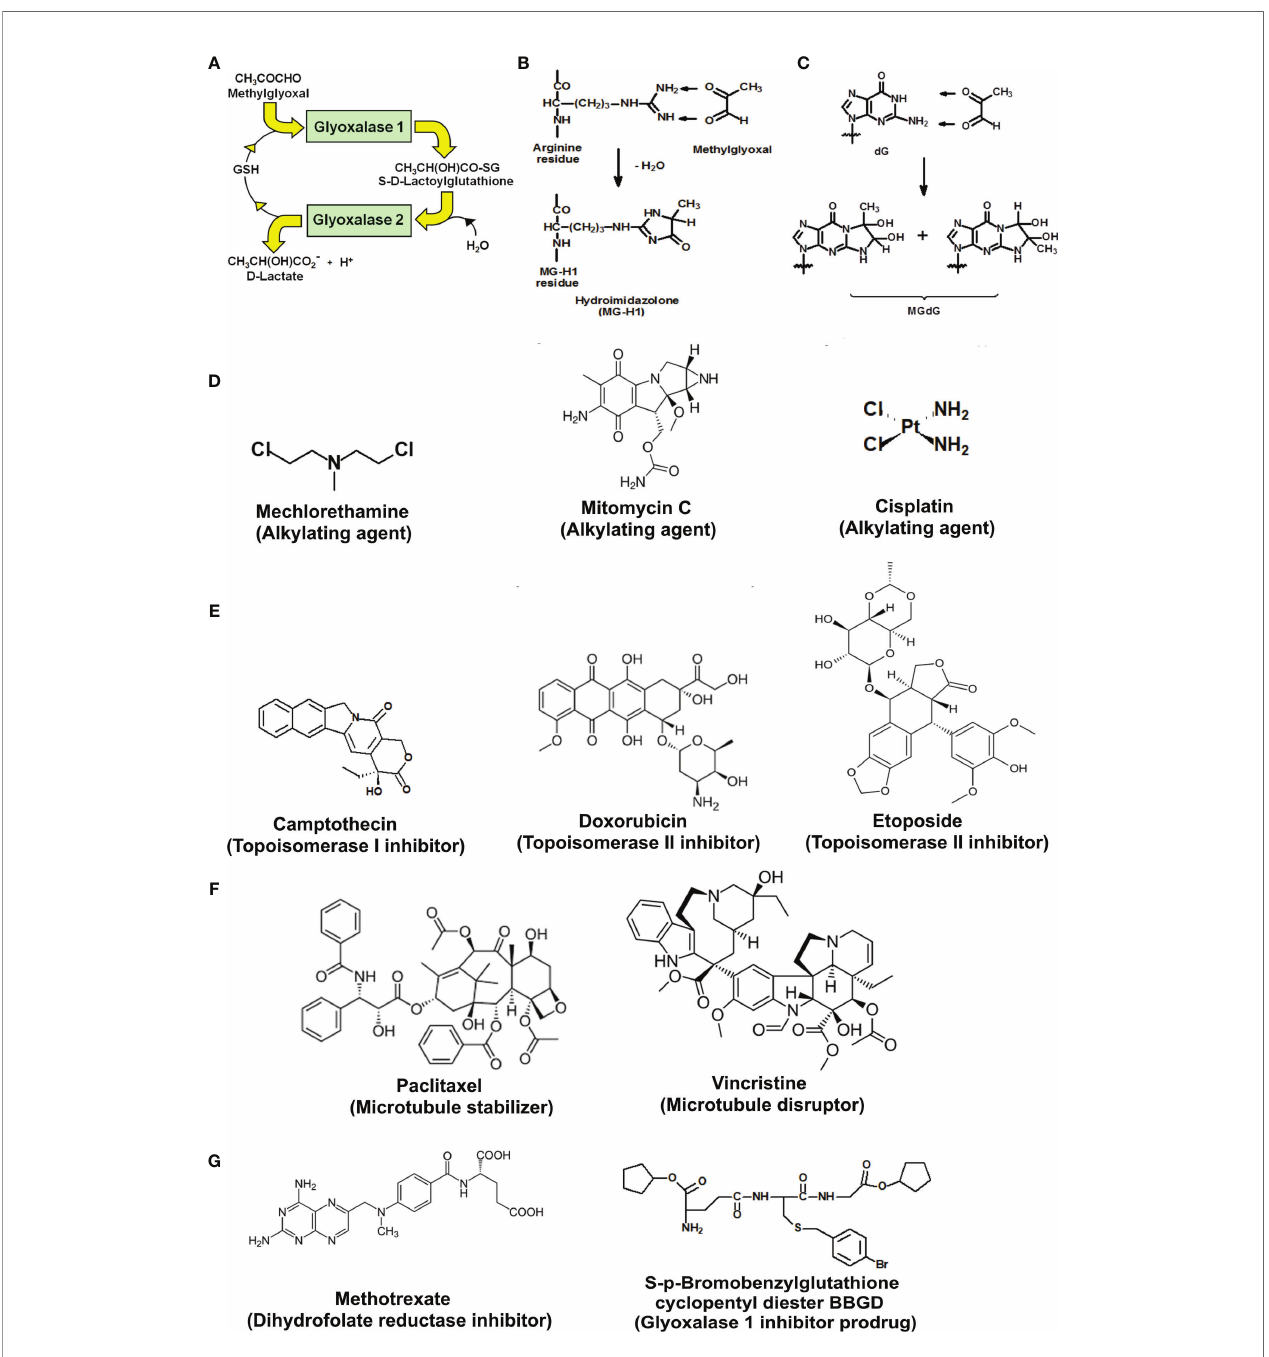
FIGURE 1 | Metabolism of methylglyoxal by the glyoxalase pathway, major glycation reactions of methylglyoxal and clinical and investigational antitumor drugs. (A) Metabolism of methylglyoxal by the glyoxalase pathway. (B) Glycation of arginine residues by methylglyoxal from hydroimidazolone, MG-H1. (C) Glycation of guanyl moieties of DNA by methylglyoxal from isomeric imidazopurinones, MGdG. (D – G) Molecular structures of antitumor drugs. (D) Alkylating agents: mechlorethamine, mitomycin C, and cisplatin. (E) Topoisomerase inhibitors: camptothecin, doxorubicin, and etoposide. (F) Antitubulins: paclitaxel and vincristine. (G) Antimetabolites: methotrexate and glyoxalase 1 inhibitor prodrug, S - p -bromobenzylglutathione cyclopentyl diester